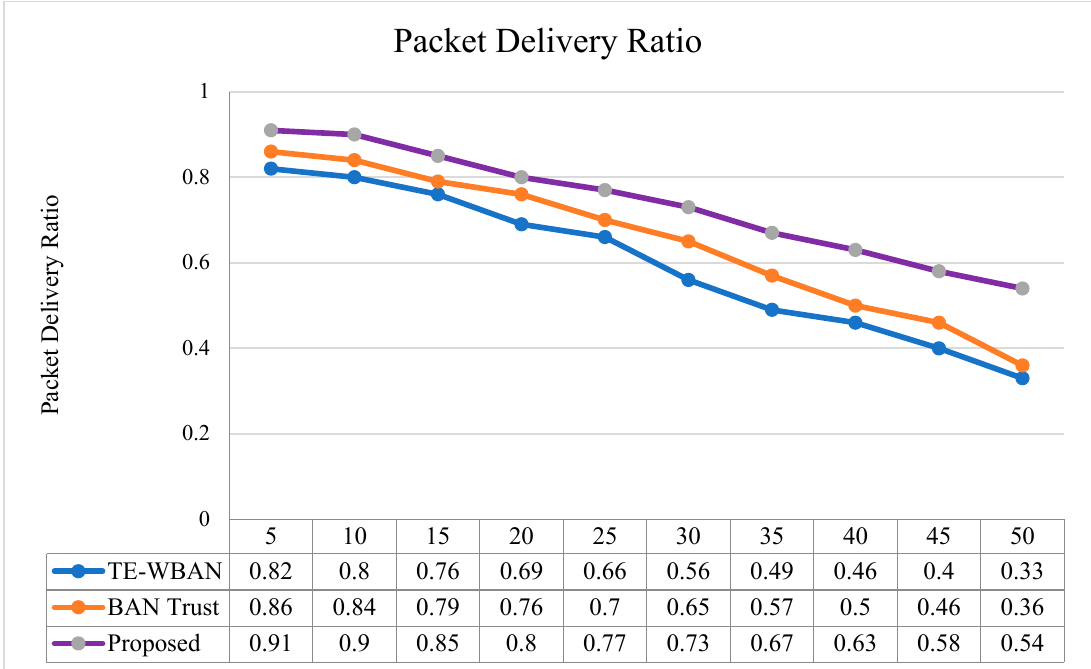
Figure 2. Packet Delivery Ratio.